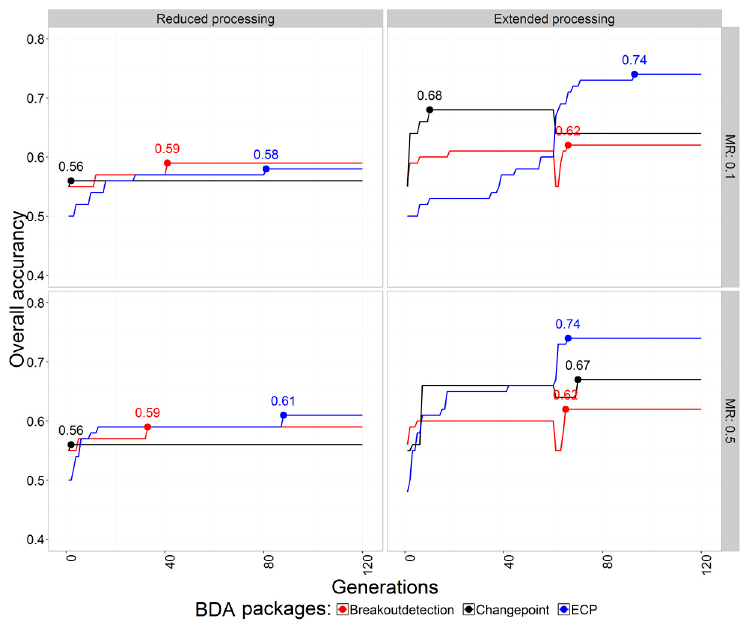
Figure 11. BDA fitness value evolution.